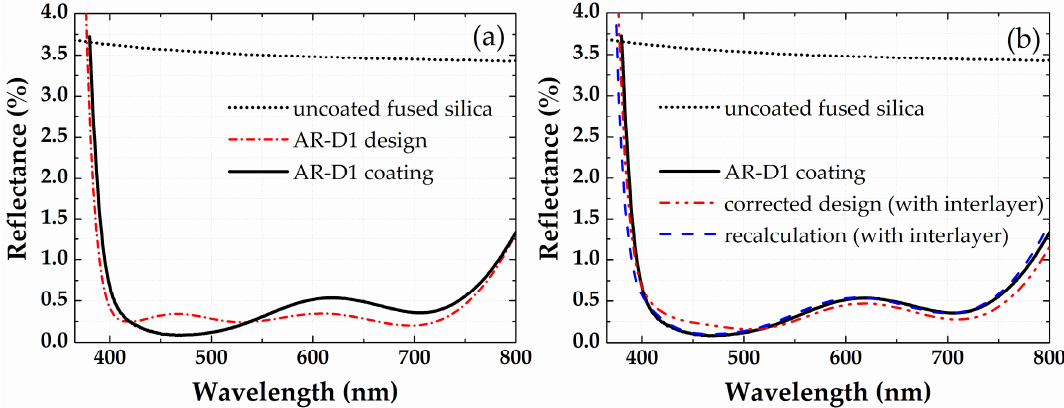
Figure 3. Reflectance spectra of AR-D1 on fused silica reference glass substrate: ( a ) Design and coating; ( b ) Corrected design (with interlayer) and recalculation from measured spectra (taking the Al 2 O 3 interlayer into account).